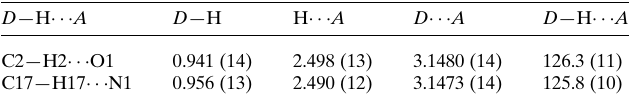
Table 1 Hydrogen-bond geometry (A˚ , (cid:2) ).